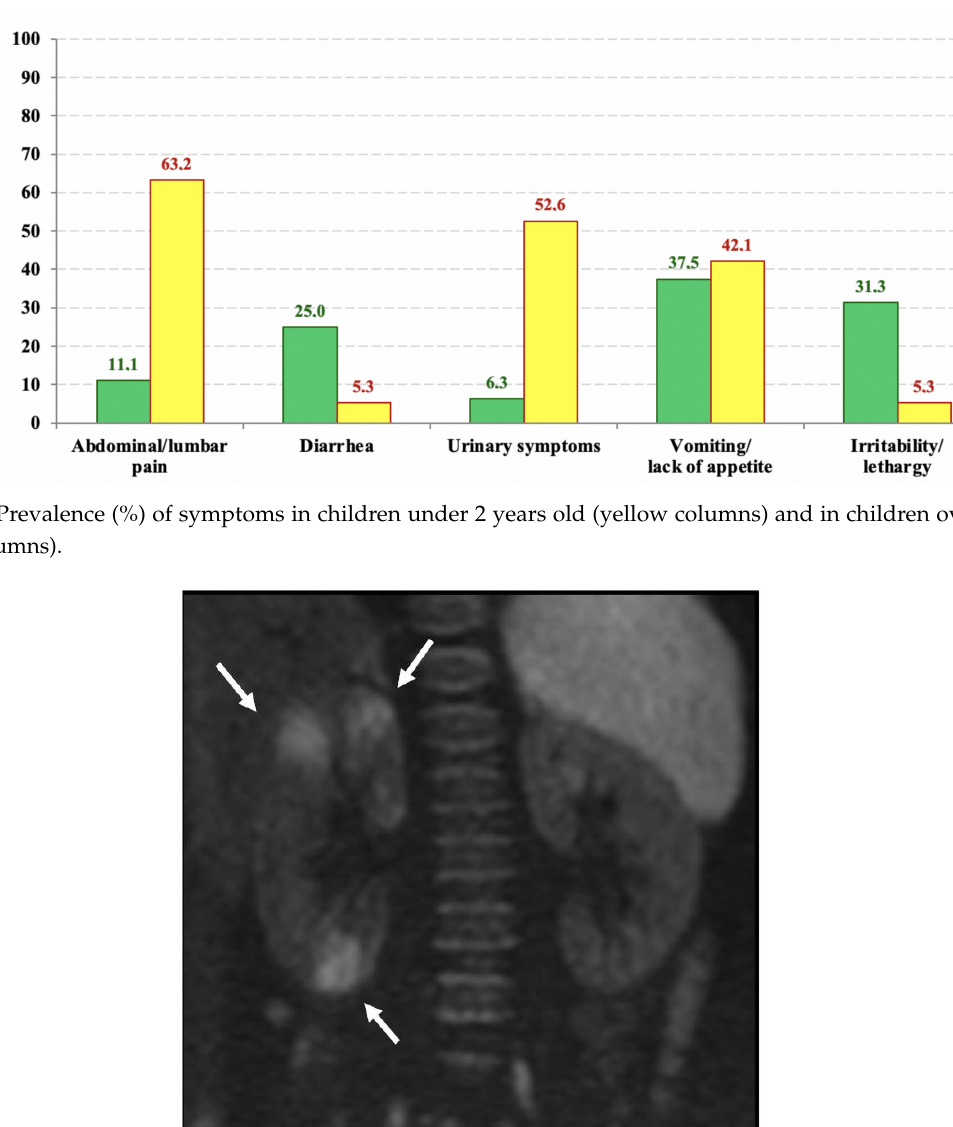
Figure 1. Prevalence (%) of symptoms in children under 2 years old (yellow columns) and in chil- dren over 2 years old (green columns).